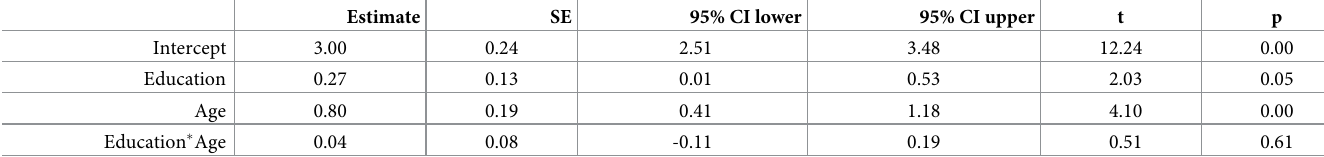
Table 3. Output for regression: Giver-Level � Education + Age + Education � Age. The predictors are continuous and de-meaned. Estimate Intercept